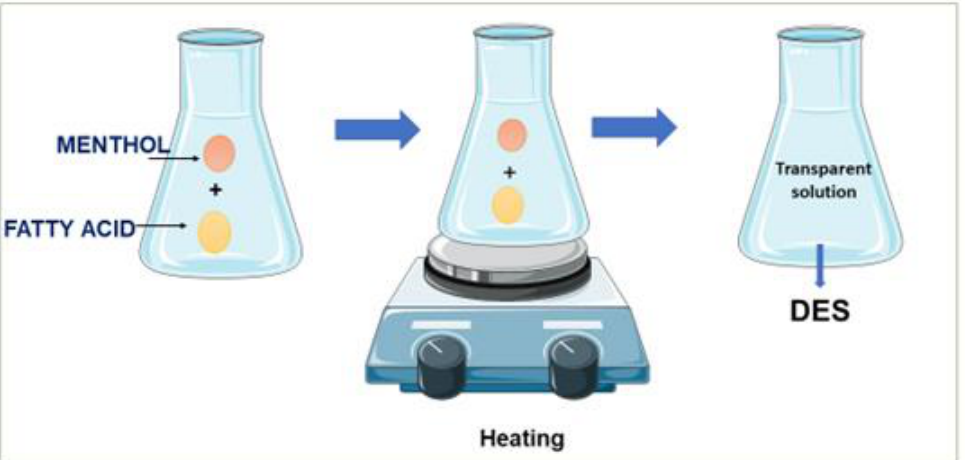
Figure 13. Schematic of hydrophobic deep eutectic solvent synthesis.